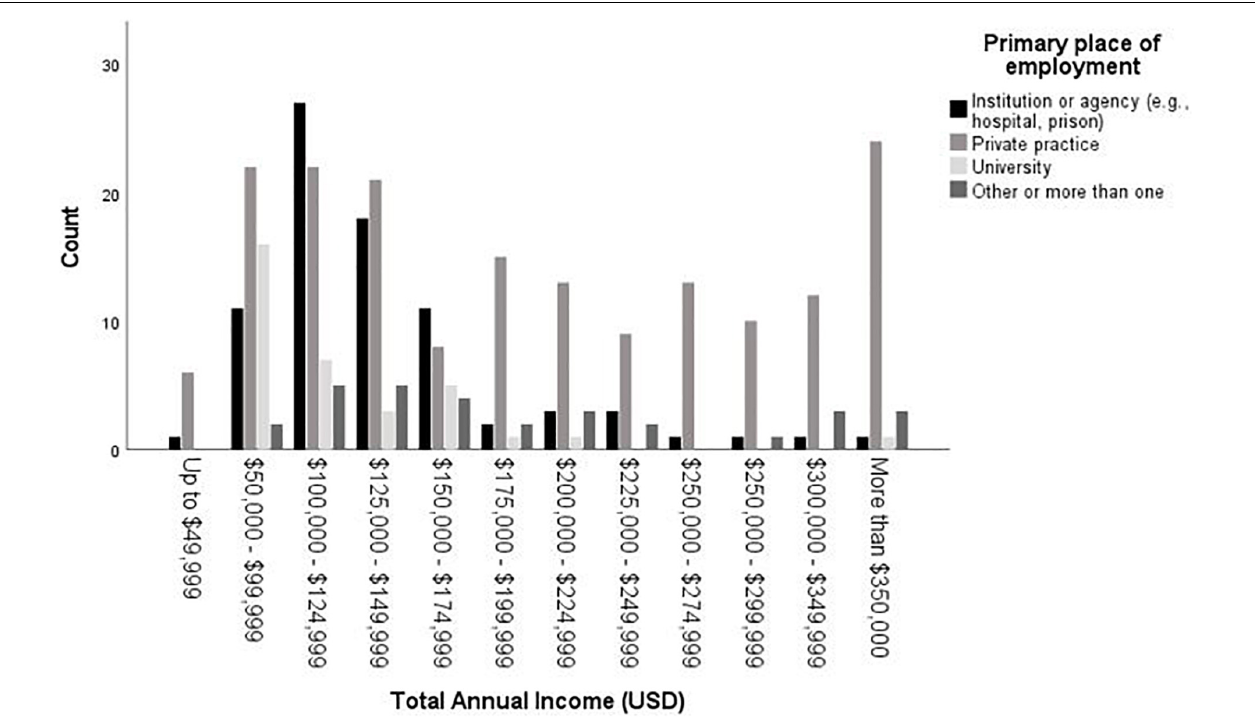
FIGURE 5 | Total annual income (USD) by primary place of